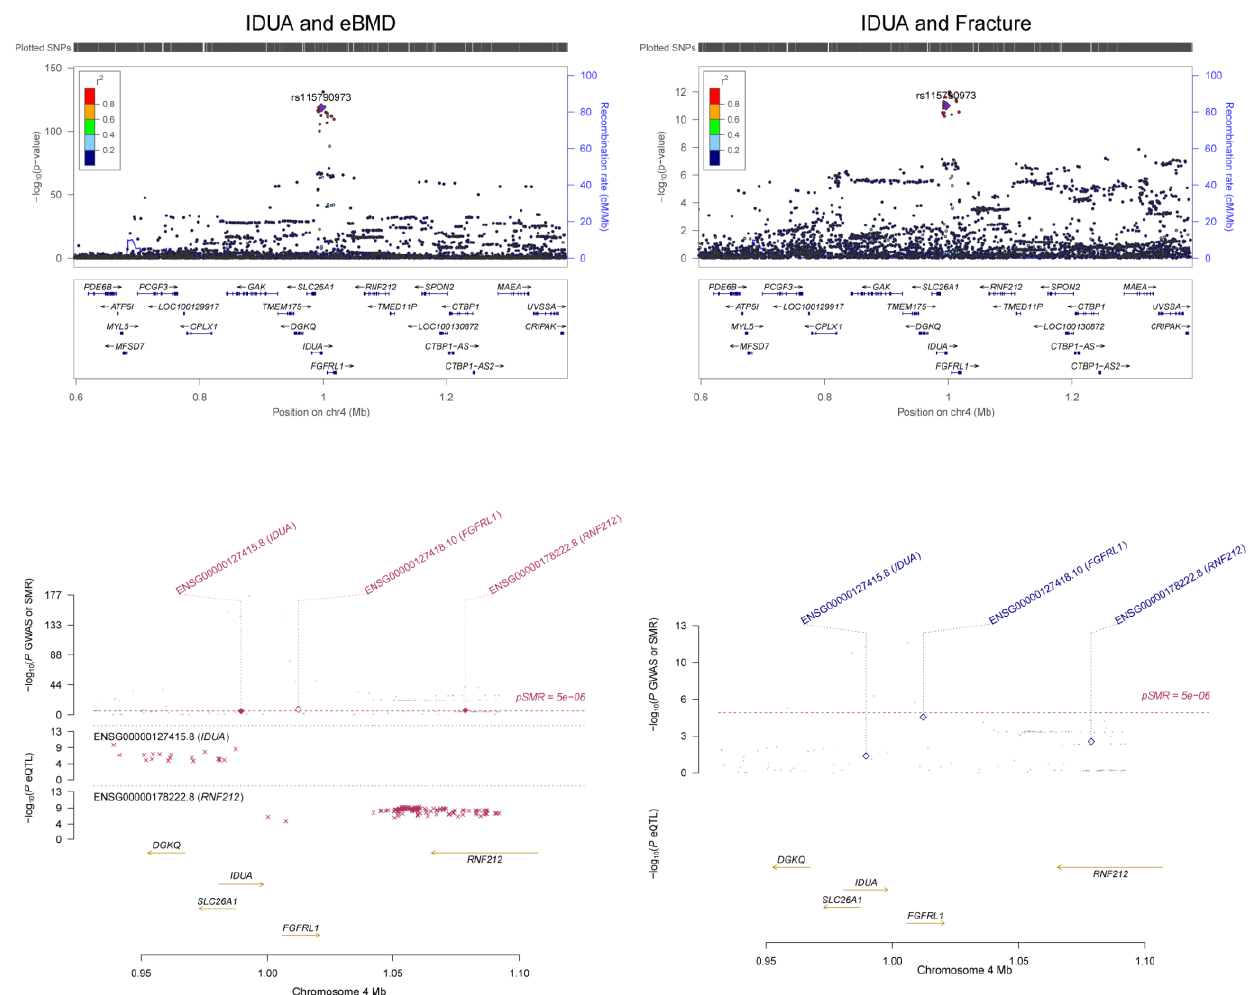
Figure 2. Association between the IDUA gene and eBMD . The m 6 A-SNP rs6815946 in the IDUA gene was associated with eBMD and fracture. The expression levels of the FGFRL1 gene in skeletal muscle were associated with eBMD and fracture.